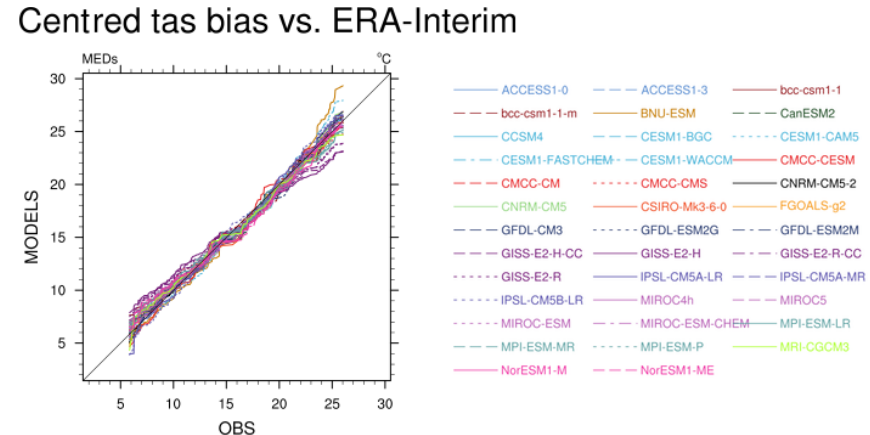
Figure 16. Ranked modelled versus ERA-Interim mean temperature for 38 CMIP5 models in the Mediterranean region (defined as in Fig. 14) for the 1979–2000 period. Similar to Fig. 9.41b of the IPCC AR5 report (Flato et al., 2013) and produced with recipe_flato13ipcc.yml ; for details see Sect. 3.4.1.